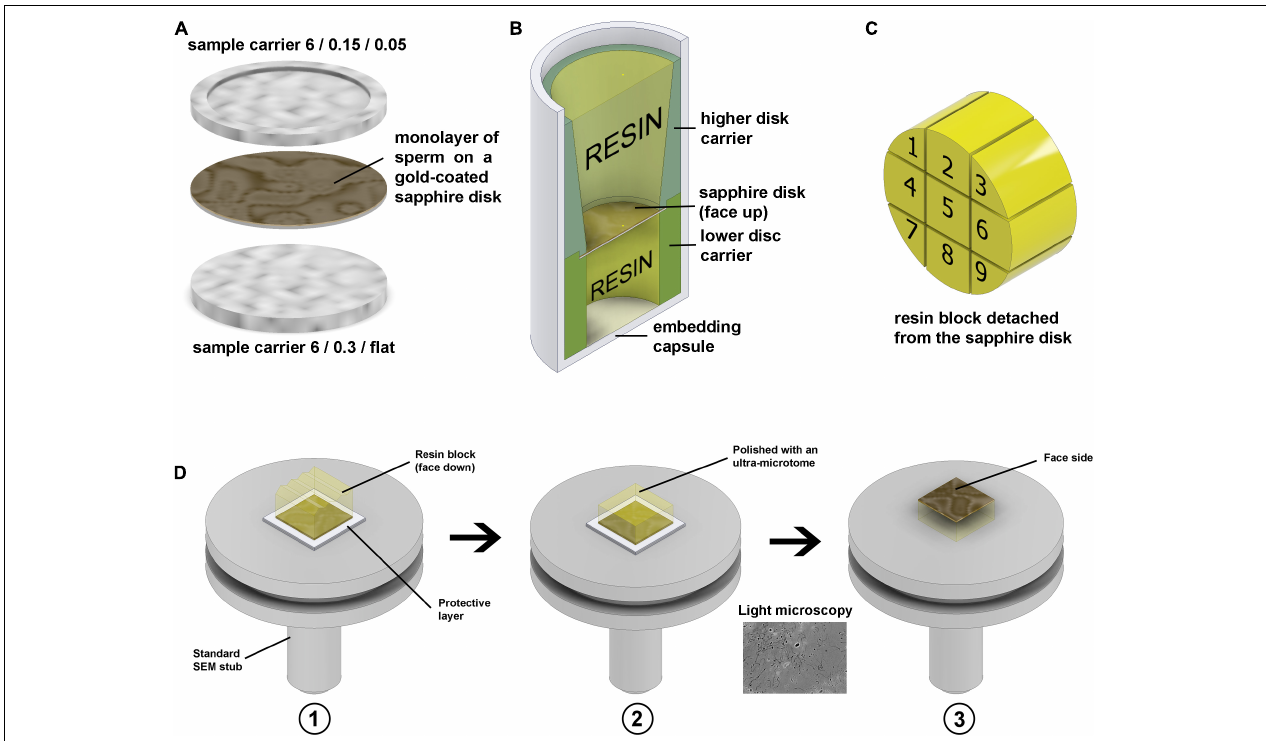
FIGURE 9 | Freezing and resin block preparation. (A) Gold-coated sapphire disk with a monolayer of sperm between 6 mm aluminium carriers for high-pressure freezing. (B) Resin embedding into a plastic capsule using custom 3D-printed carriers. (C) Division of the 6 mm block to nine sub-blocks. (D) To make the top surface of the block parallel to the stub face it was glued to the stub with face side down, using parafilm as a protector in panel (D1), then the top surface was polished parallel to the stub in panel (D2), and then the block was detached, flipped and glued back with the face side up in panel (D3). The thin gold layer on the face surface of the block is semi-transparent, thus after detachment from the stub, it can be examined under a conventional light